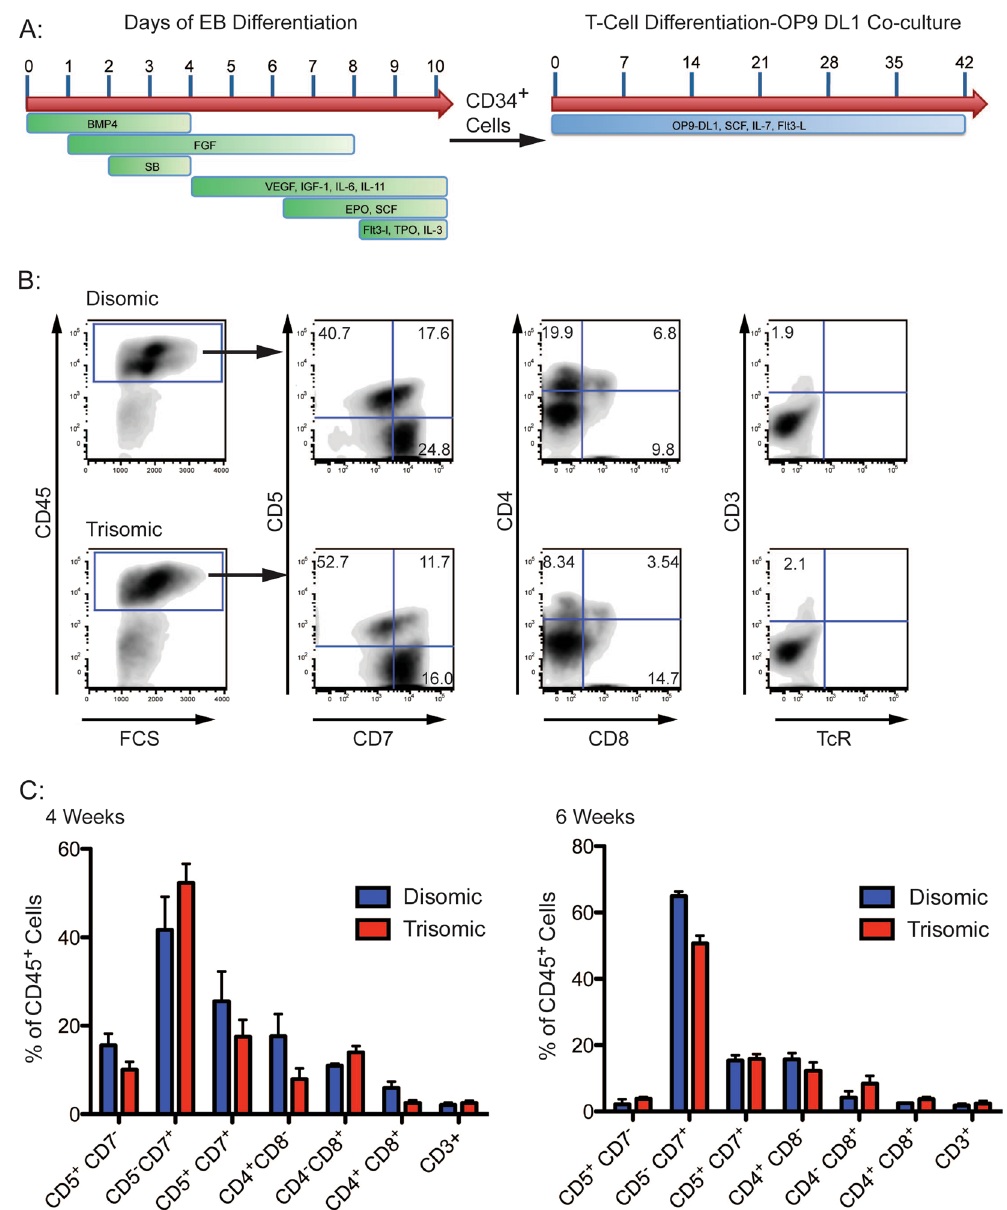
Figure 2. Disomic and Trisomic Isogenic iPS cells Show Comparable Efficiency in T Cell Differentiation. ( A ) Differentiation conditions for generation of T cells from isogenic iPS cells. ( B ) FACS analysis showing distribution of CD5/CD7, CD4/CD8 and CD3/TcR α / β cells within CD45 + populations. ( C ) Quantification of FACS analysis for T cell progenitor populations, no significant differences were observed between disomic and trisomic clones for any population analyzed after either 4 or 6 weeks of